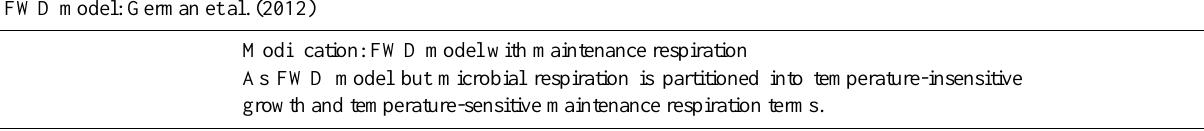
Table 1. Key features of the microbial decomposition models and subsequent modifications presented in this study. FWD model: German et al. (2012) Modification: FWD model with maintenance